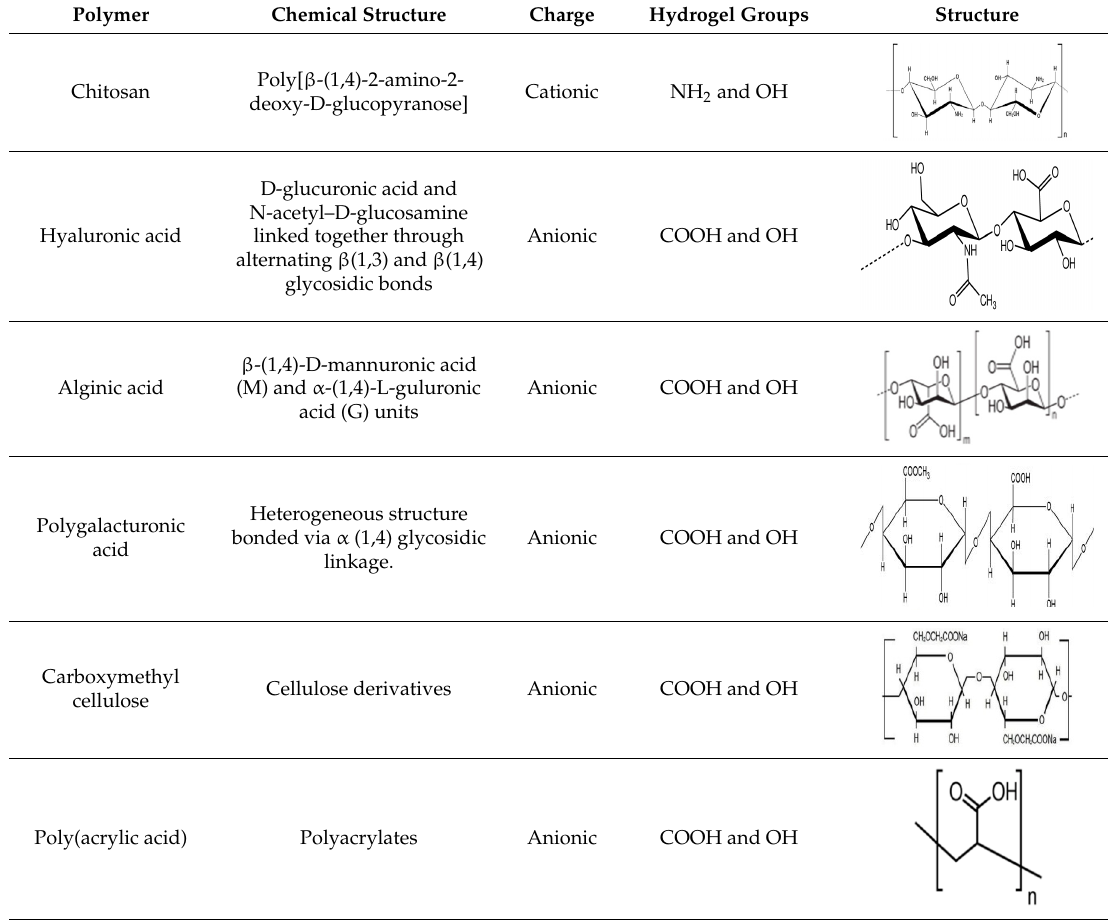
Table 3. Polymers used to optimize mucoadhesive systems.